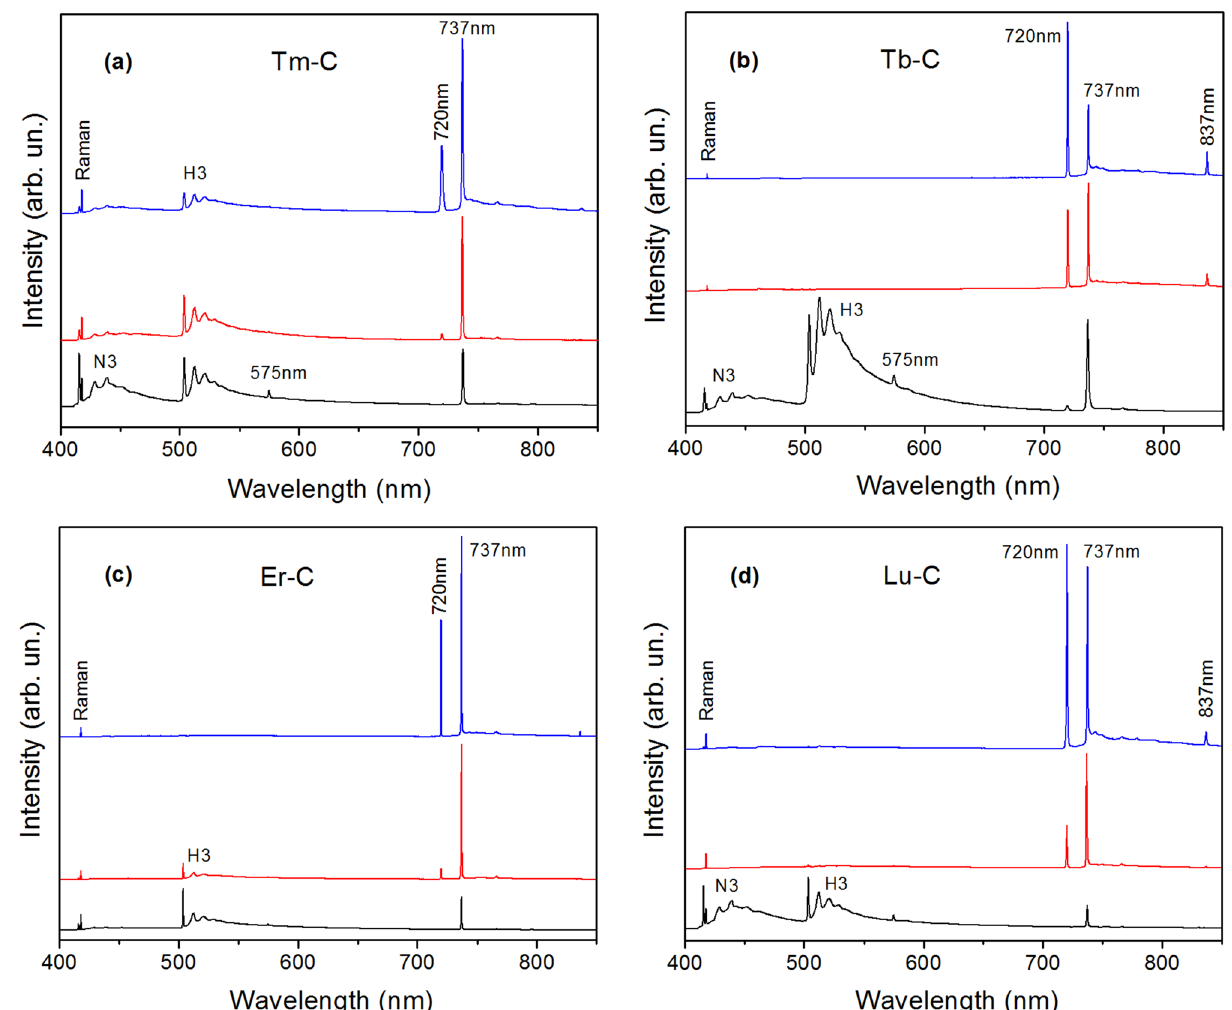
Figure 6. Representative PL spectra of diamonds produced using heavy rare earth catalysts. The spectra were recorded at 80 K with excitation of 395 nm for diamonds synthesized in ( a ) Tm–C, ( b ) Tb–C, ( c ) Er–C and ( d ) Lu–C systems at 2000 °C. The spectra in each panel were normalized to show the same intensity of the diamond Raman peak and displaced vertically for clarity.